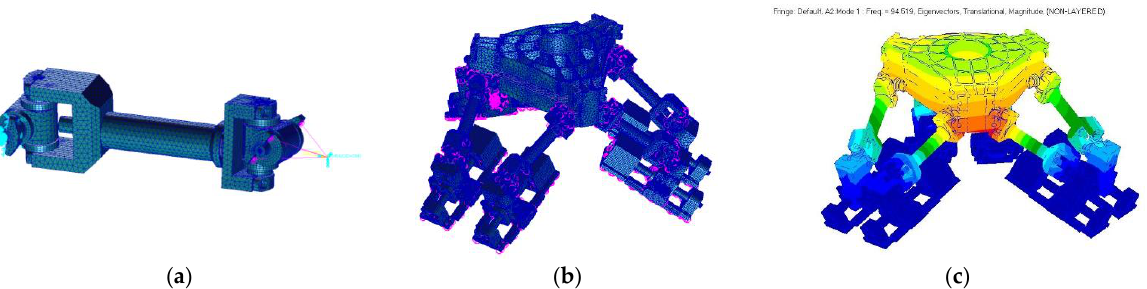
Figure 17. Finite element simulation of the third mirror adjustment mechanism: ( a ) Equivalent finite element model of subchain; ( b ) Finite element model of the whole mechanism; ( c ) Result of the finite element modal analysis.